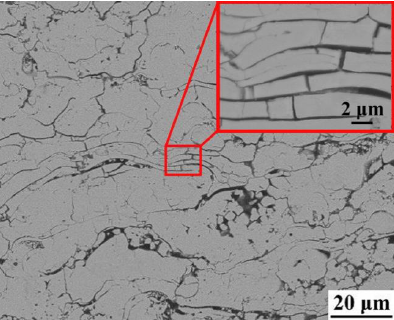
Fig. 29 2D pore network formed by the connection of inter-splat pores and intra-splat cracks. Reproduced with permission from Ref. [7], © ASM International